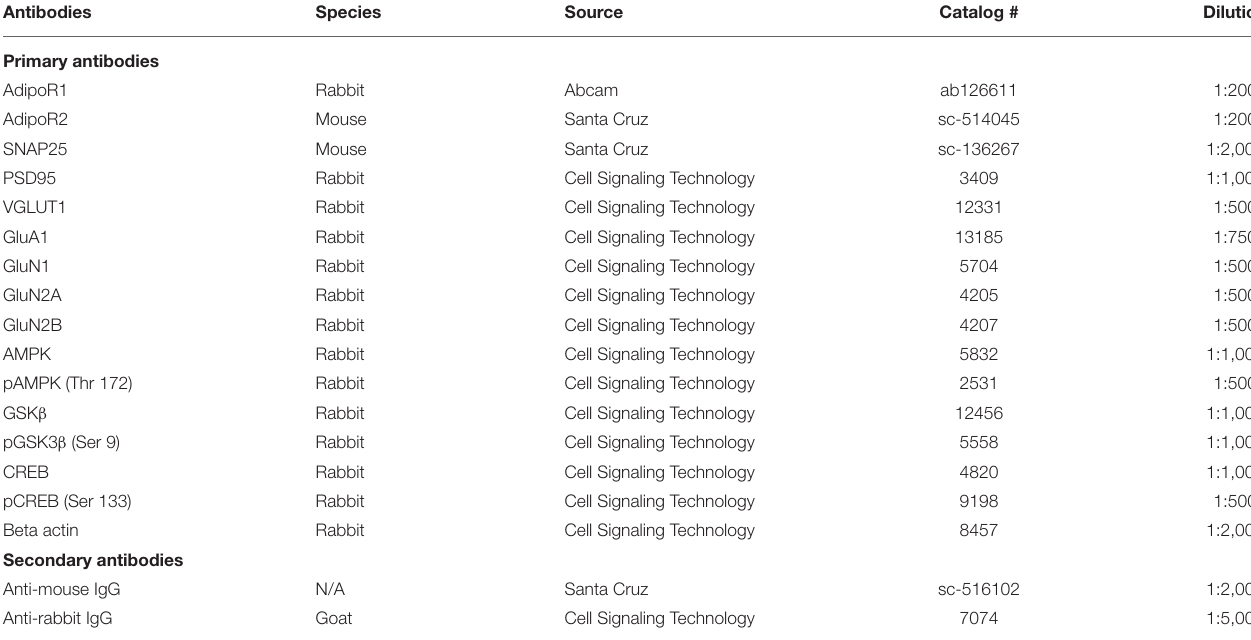
TABLE 1 | Summary of antibodies and working conditions used in the experiments. Antibodies Species Source Catalog # Dilution Primary